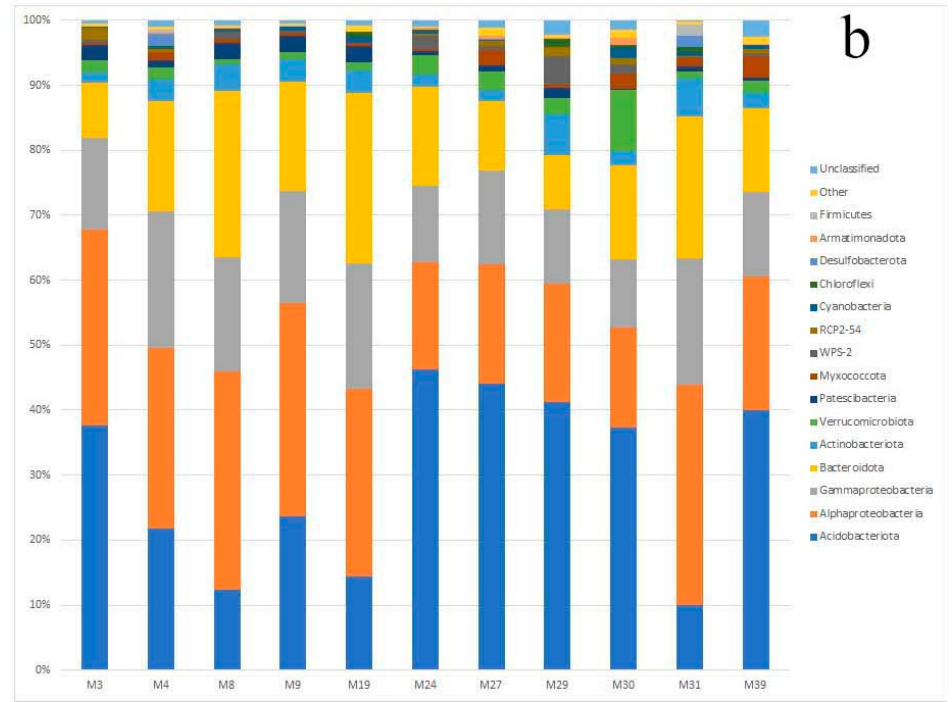
Figure 3. The number of bacterial sequences ( a ) and the taxonomic structure at the phylum level of the bacterial community of the studied soils in % of the total number of sequences in the sample ( b ) according to high-throughput sequencing of 16s rRNA. The median value of the three replicate samples per sampling site is presented. The taxa constituting >1% in at least one library are listed.